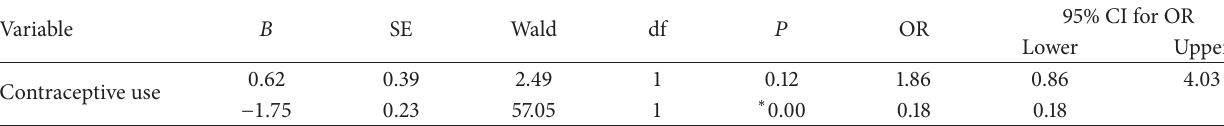
Table 5: Logistic regression model predicting likelihood of hormonal contraceptives as a cause of hypertension among female subjects. Variable 𝐵 SE Contraceptive